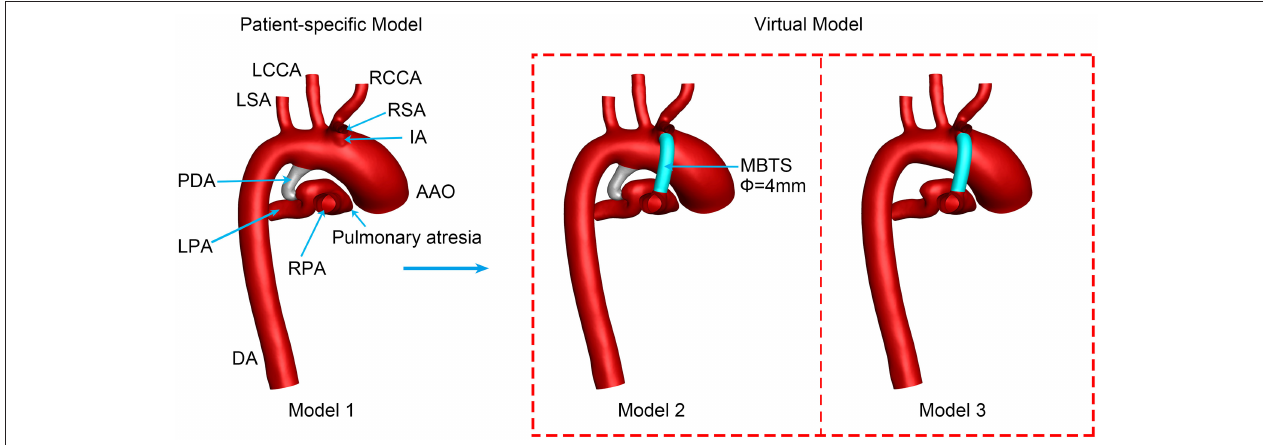
FIGURE 1 | Three-dimensional vascular models. PDA, patent ductus arteriosus; MBTS, modified Blalock-Taussig shunt; AAO, ascending aorta; DA, descending aorta; RSA, right subclavian artery; RCCA, right common carotid artery; RPA, right pulmonary artery; LCCA, left common carotid artery; LSA, left subclavian artery; LPA, left pulmonary artery; Φ , diameter.